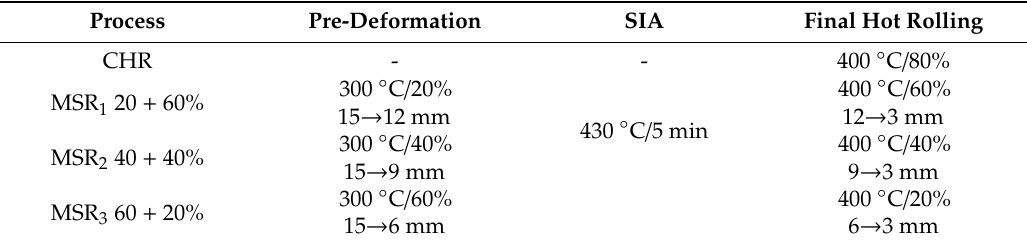
Table 2. Specific process parameters.